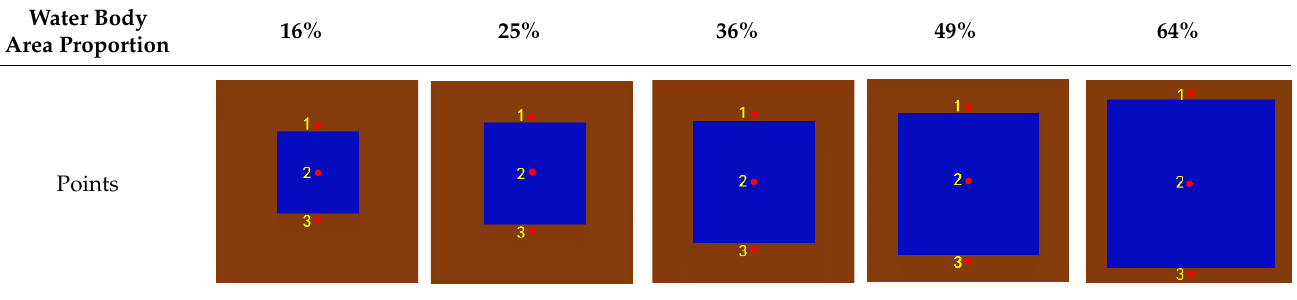
Table 3. Distribution of points in each area.